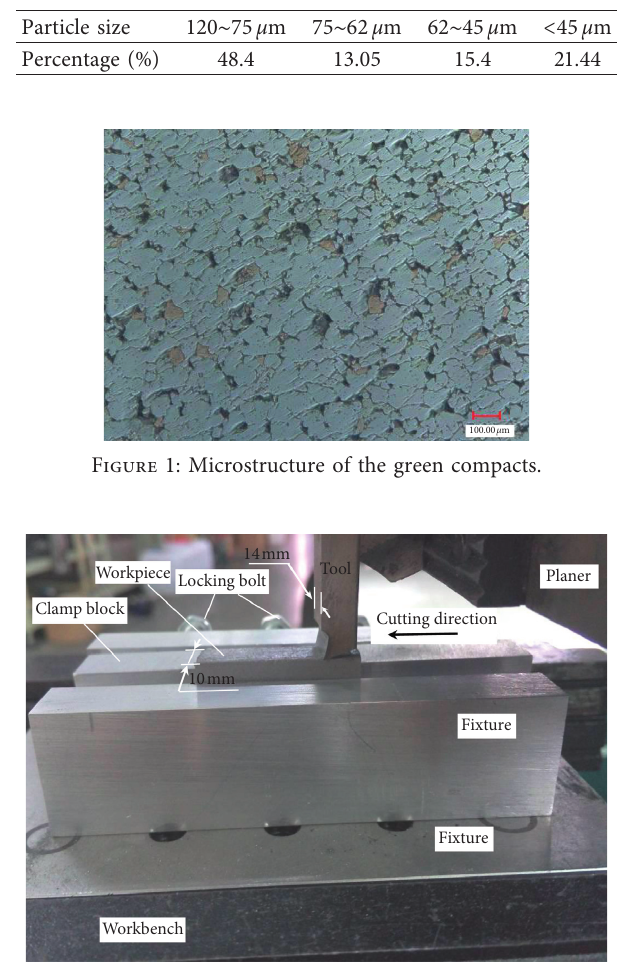
Figure 2: Orthogonal cutting experiment